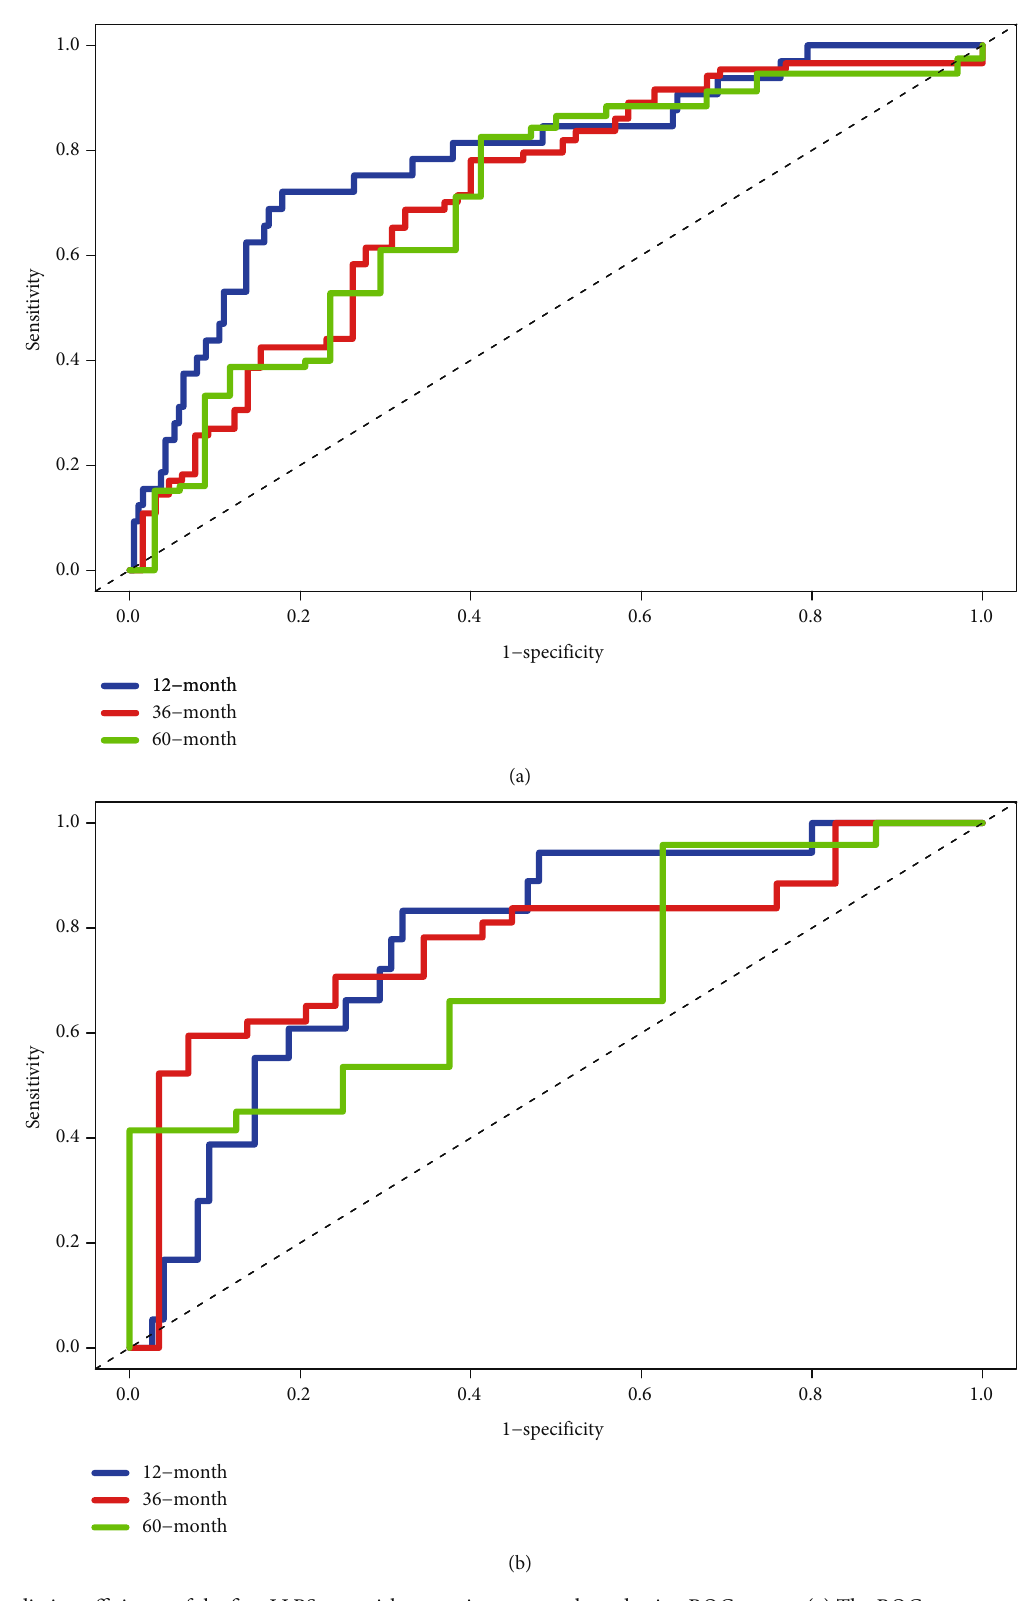
Figure 4: Prediction e ffi ciency of the fi ve-LLPS gene risk score signature evaluated using ROC curves. (a) The ROC curves are shown for the risk score signature in the training dataset. (b) The ROC curves are shown for the risk score signature in the validation